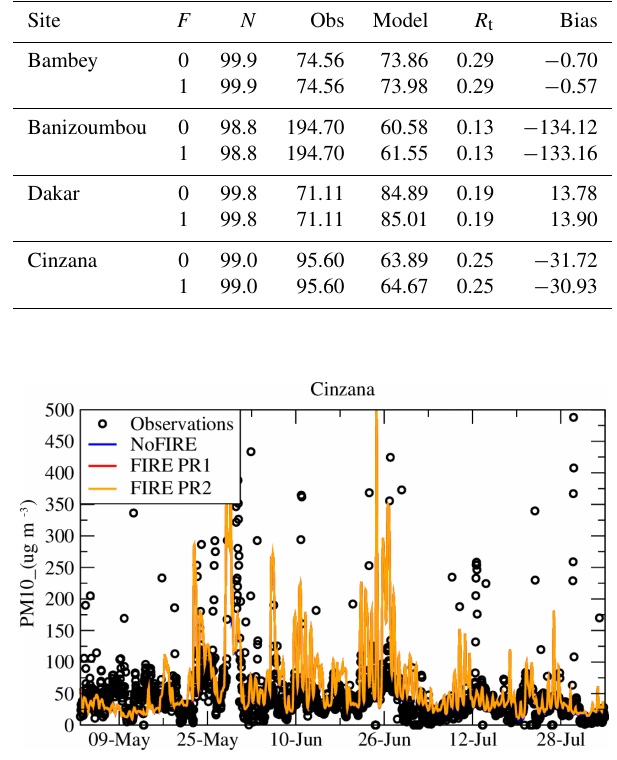
Figure D2. PM 10 surface concentration time series measured with the Sahelian Transect Network and modelled with the NoFIRE and the FIRE PR1 and PR2